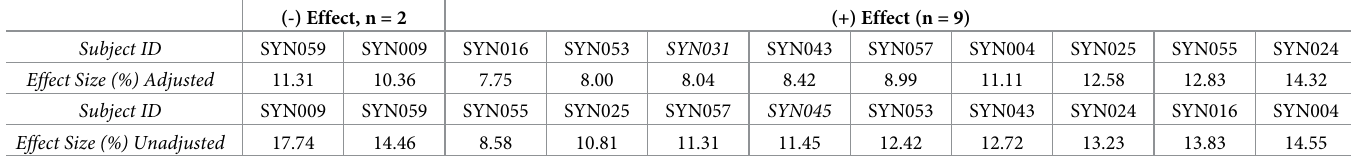
Table 5. The subject IDs and effect sizes for the top quartile of participants as selected by their adjusted and unadjusted facilitation effects Average from the group experiment.